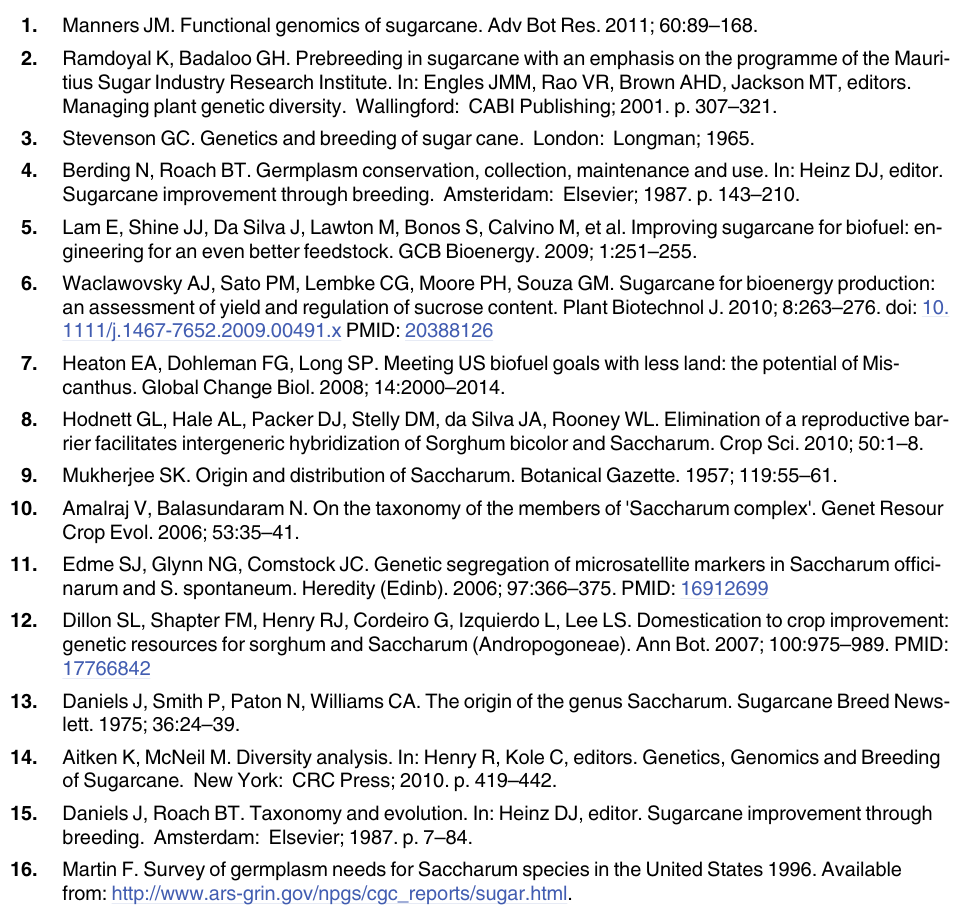
S2 Table. A list of top four KEGG pathways obtained by KEGG pathway mapping with dif- ferentially expressed genes in CP72-1210 and TUS05-05 after chilling stress.